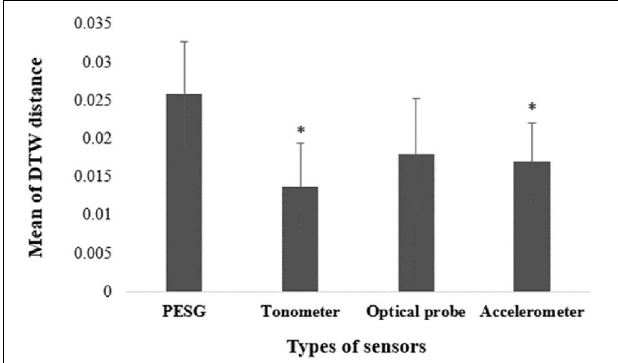
FIGURE 4 | Mean of DTW distance measured with the four sensors [ ∗ marks significant differences in comparison with PESG ( p < 0.05)].